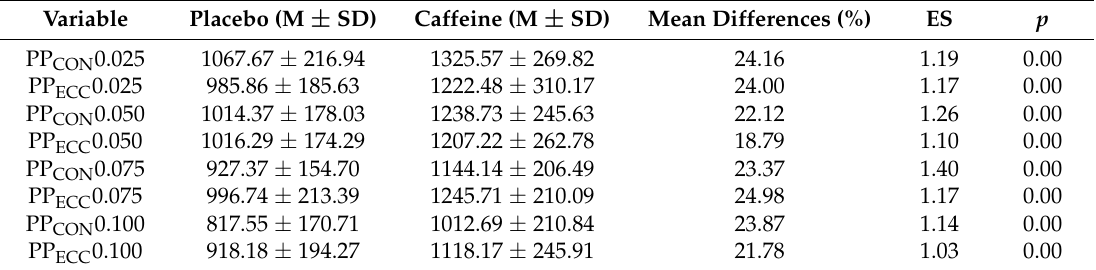
Table 2. Effects of caffeine ingestion on concentric (CON) and eccentric (EEC) peak power (PP) out- comes (W) at different inertias compared to the placebo condition.